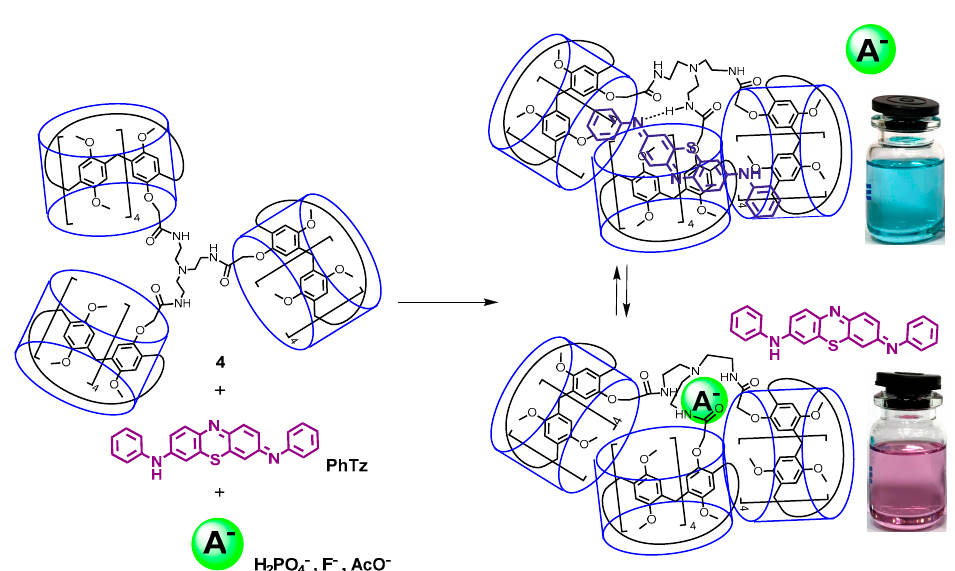
Figure 1. Scheme of complex formation of compound 4 with PhTz and competitive complexation with anions.